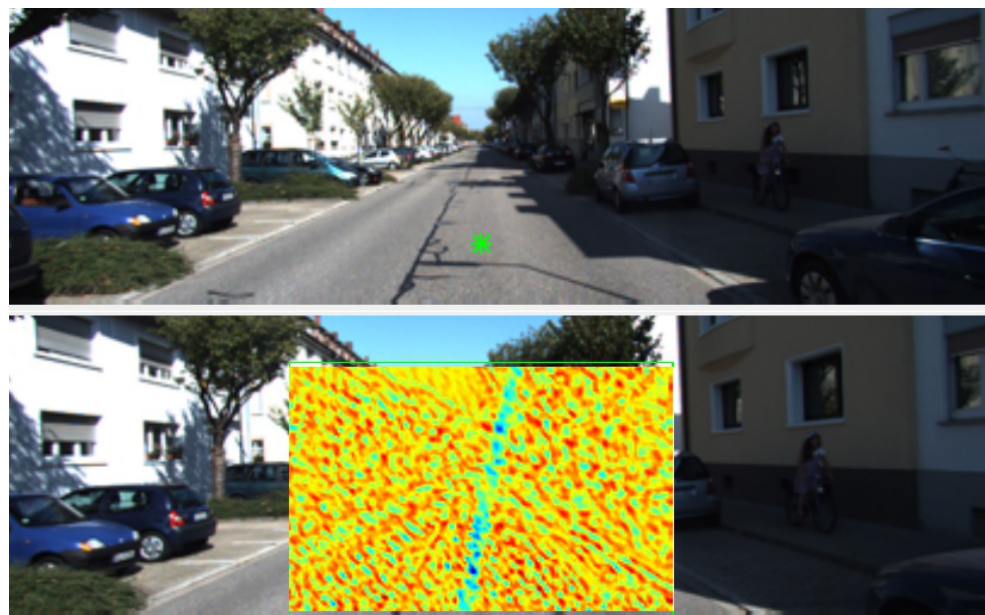
Figure 2. An example illustrating the epipolar constraint added to a cost slice from two consecutive images. ( top ) The first image shows a pixel marked by a green star. ( bottom ) The second image shows a bounding box enclosing the candidate-matching pixels for the corresponding pixel in the first image, with the matching cost of corresponding candidate pixels. Red colour represents low- matching candidates and blue for high matching. The epipolar line (a straight line towards an epipole) shows highly likely